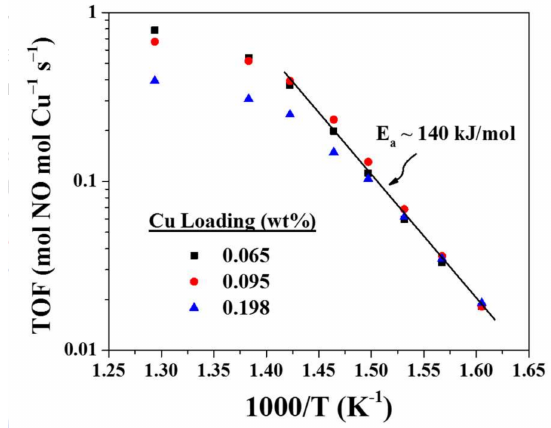
Figure 14. Turnover frequencies (TOFs, mol NO mol Cu − 1 s − 1 ) as a function of temperature in Arrhenius plots for low Cu loaded Cu/SSZ-13 (Si/Al = 6). The reactant feed contains 350 ppm NO, 350 ppm NH 3 , 14% O 2 , 2.5% H 2 O balanced with N 2 at a GHSV of 1,200,000 h − 1 . Different symbols represent samples with different Cu loadings. Reprinted from J. Catal. , 2014 , 319 , 1–14. Copyright 2014, with permission from